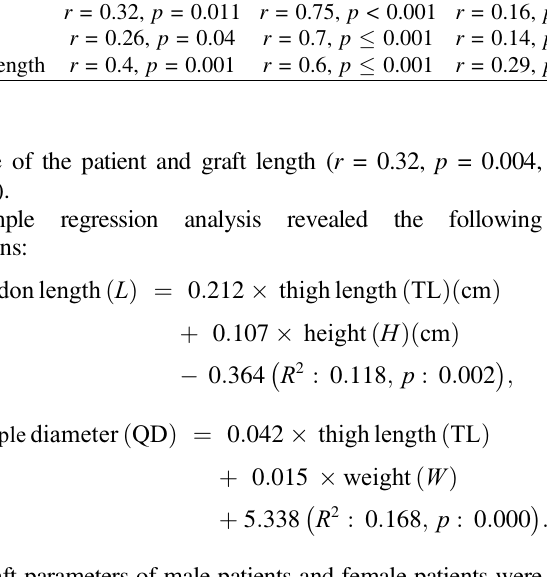
Graft parameters of male patients and female patients were analysed separately. The correlation has been tabulated in Table 4. Simple regression equations for male and female patients